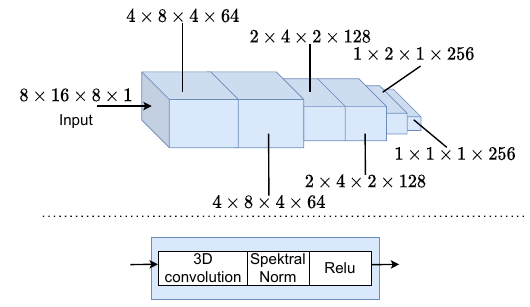
Figure 4. The network Θ( · ) encodes a block of size 8 × 16 × 8 into a feature vector of size 1 × 1 × 1 × 256